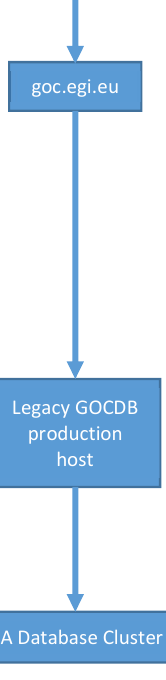
Fig. 5 The historical GOCDB service architecture (left) and the current GOCDB service architecture (right). In future, GOCDB will itself be moved to a highly available setup, having two configuration managed hosts providing the service and the current production machine will be decommissioned, this setup is shown in Fig.